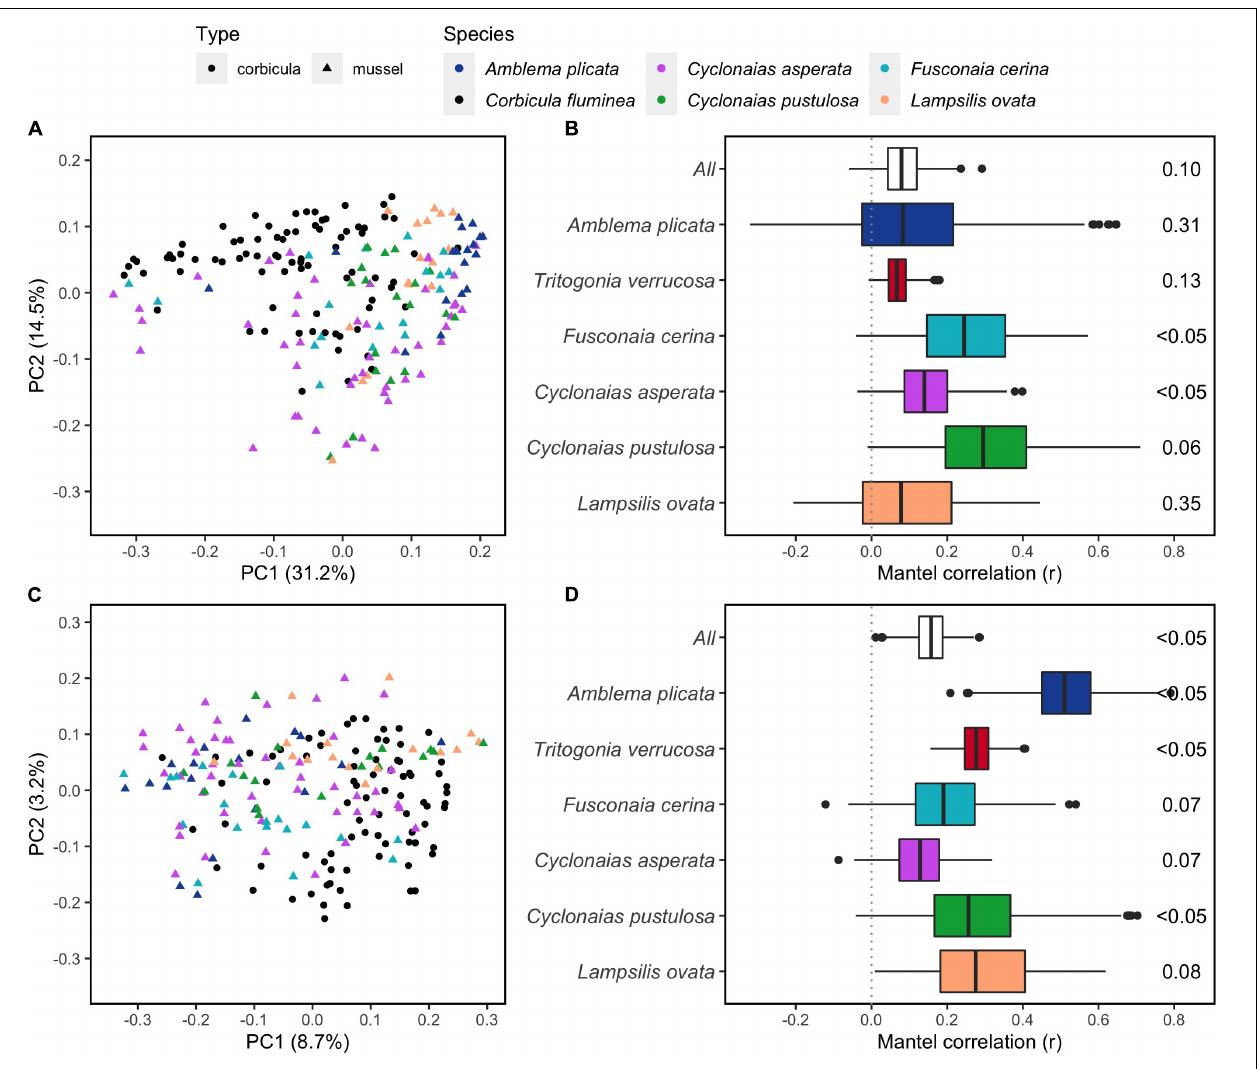
FIGURE 3 | Dissimilarities between gut microbiomes of six native freshwater mussel species and the invasive clam Corbicula fluminea , collected from rivers in the Tennessee and Mobile River Basins. A and C: Principal Coordinate Analyses (PCoAs) representing the weighted (A) and unweighted (C) versions of Unifrac phylogenetic dissimilarity between individual microbiomes of five of the mussel species, and C. fluminea (PCoAs with all six species including T. verrucosa are available in S2- Supplementary Figure 1 ). B and D: correlations between dissimilarities of W-Unifrac (B) and U-Unifrac (D) of C. fluminea and mussel microbiomes, assessed by 500 Mantel tests on random subsamples of the same number of specimens at each site (either with all mussel species – “All,” or per species). The median of the 500 p -values, indicating an overall significant co-variation between C. fluminea and mussel microbiomes, is displayed on the right.